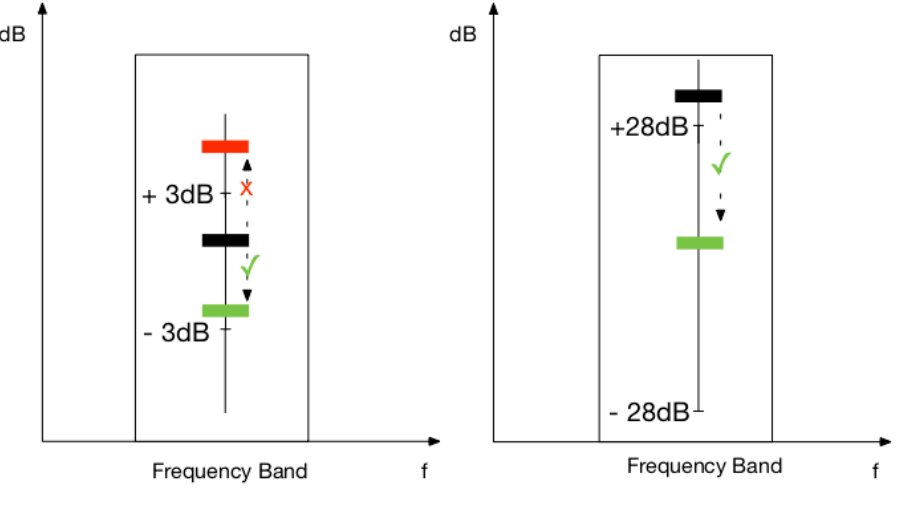
Figure 5. Frequency band energy estimation